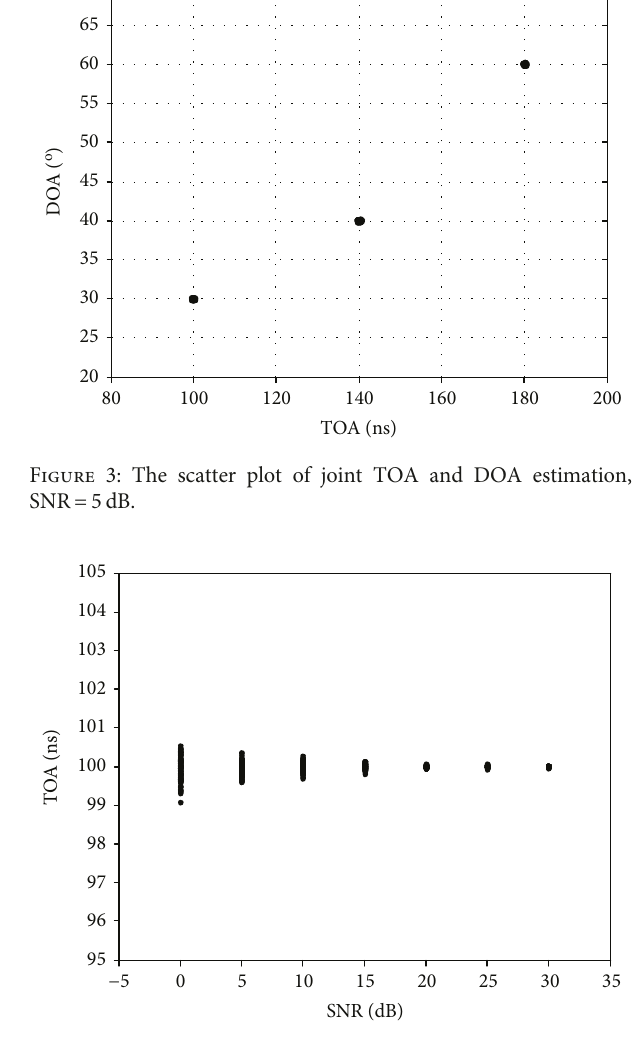
Figure 4: The scatter plot of TOA estimation under di ff erent